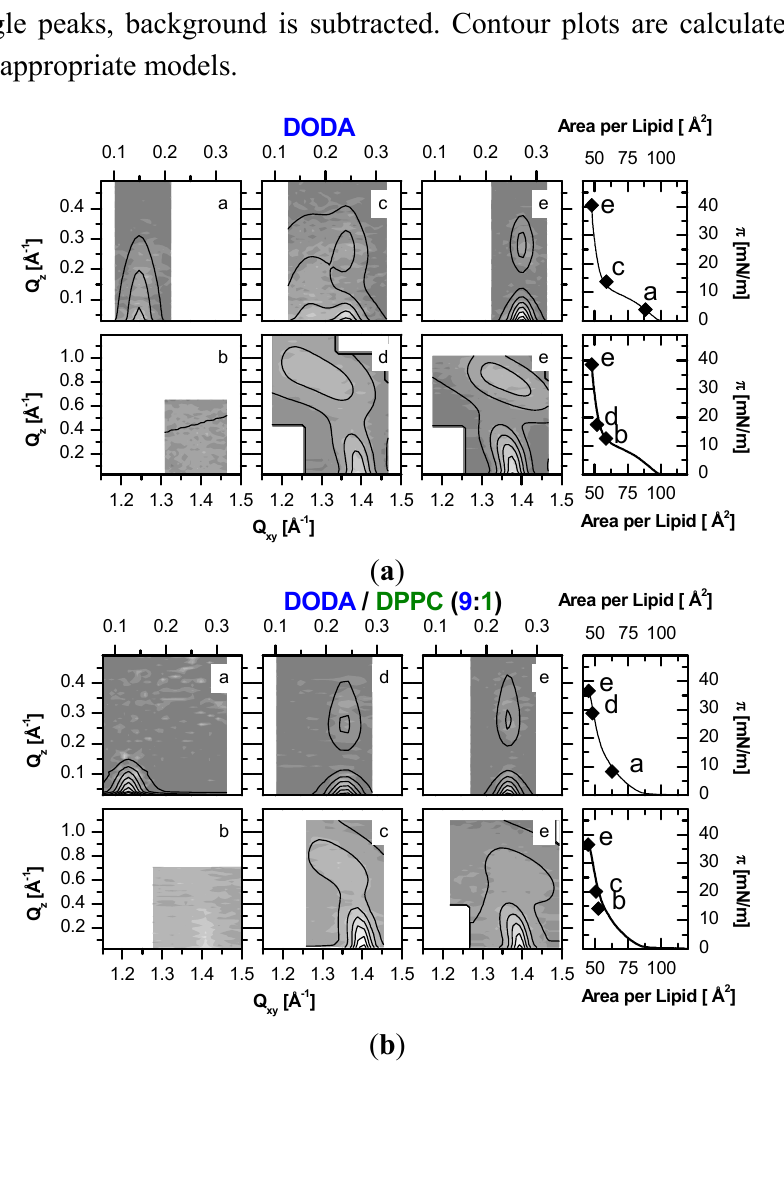
(PSS) = 16 kDa). w DPPC ( M (PSS) = 76 kDa). For 0.75 0.25 w